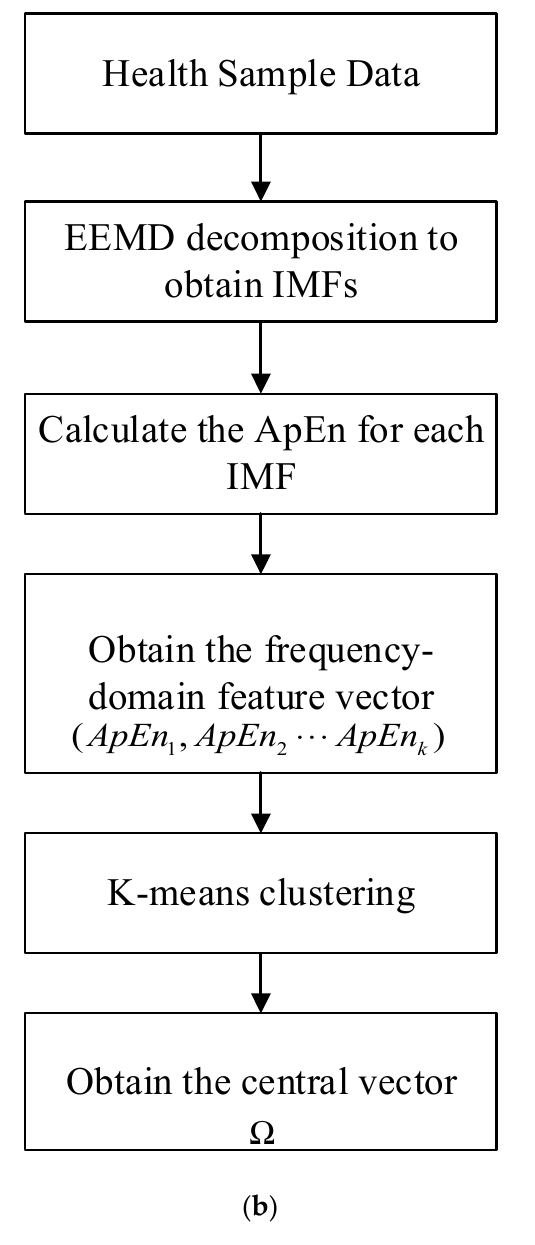
Figure 2. Flowchart of Step 1: ( a ) is the flowchart of constructing THM; ( b ) is the flowchart of constructing FHM.